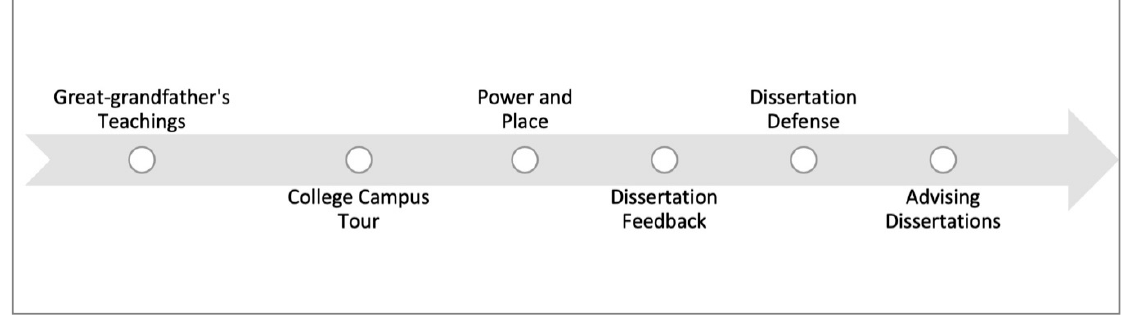
Figure 2. Linear timeline of stories.